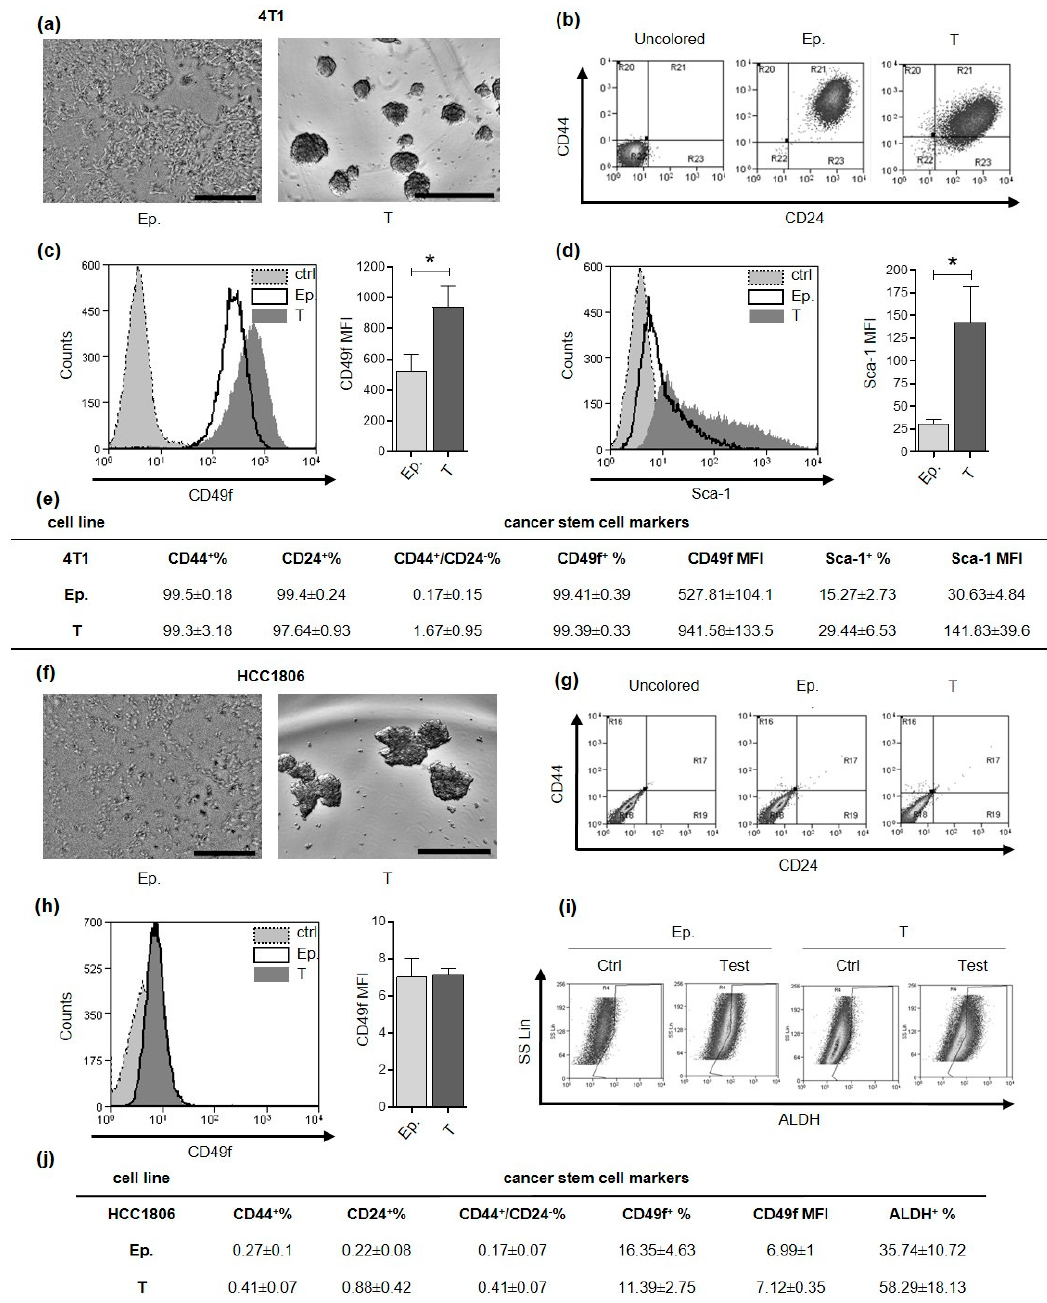
Figure 1. Tumorspheres generation and characterization. CSC markers characterization of 4T1 and HCC1806 cell lines. ( a , f ) Optical microscope pictures of sub-confluent epithelial cells and 5-day-old tumorspheres are reported. Grey scale bar: 500 µ m. ( b , g ) density plots represent the flow cytometry double staining of epithelial (Ep.) or tumorsphere-derived (T) cells for CD44 and CD24 surface markers. Flow cytometry histogram representations for CD49f ( c , h ) and Sca-1 ( d ). Gray fills with dotted lines refer to unstained control cells, no fills with black lines to Ep. cells and dark gray fills with no lines to T cells. The cell count is reported on the y-axis, the fluorescence intensity of the staining for the indicated surface marker is reported on the x-axis. Bar graphs show comparison of Mean Fluorescence Intensity (MFI) for a given marker between Ep. and T cells. ( e , j ) Tables represent the mean percentage of positive Ep. or T cells for a given marker and the MFI of a given marker ± SEM, as assessed by flow cytometry. ( i ) Density plot representation of HCC1806 cell staining for Aldehyde Dehydrogenase (ALDH) activity reports fluorescence on x-axis and side scatter (SS Lin) on the y-axis. * p <